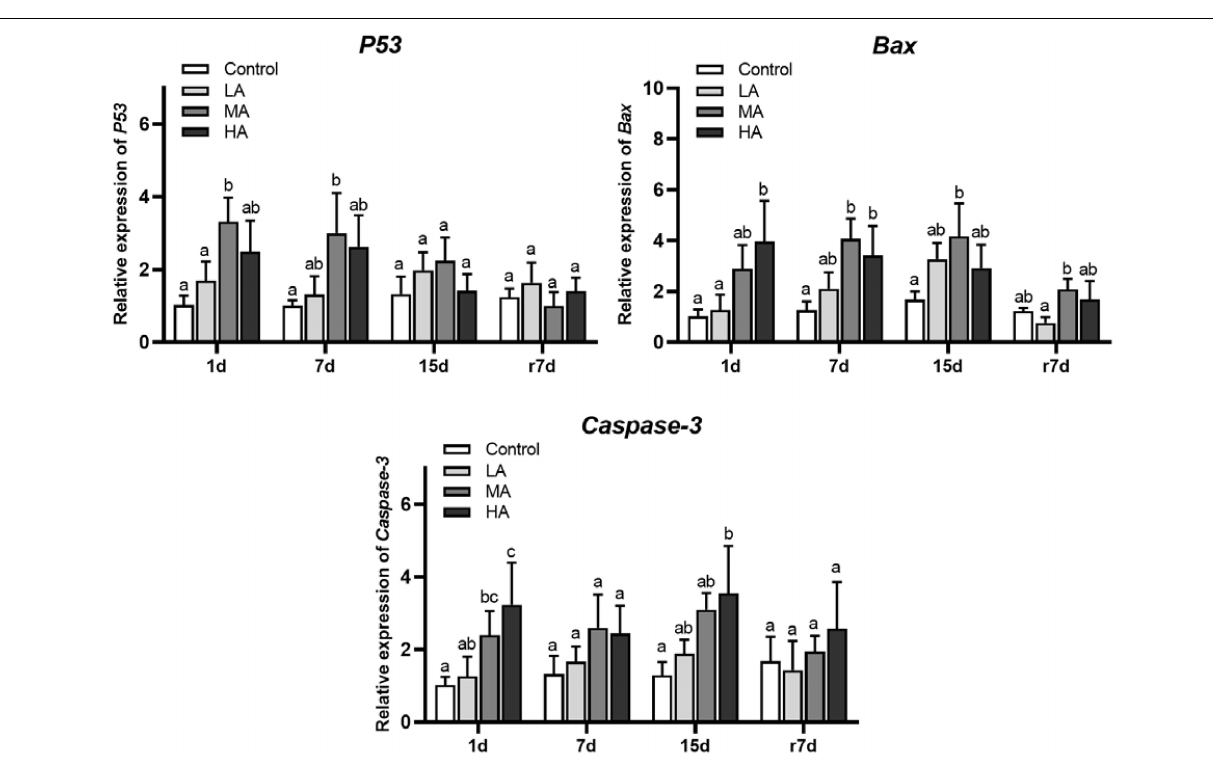
FIGURE 7 | The mRNA expression of apoptotic pathway in hepatopancreas of P. trituberculatus after ammonia exposure and recovery. Data are represented as mean ± S.D., n = 3, with P < 0.05 considered significant. Different letters represent significant differences among different